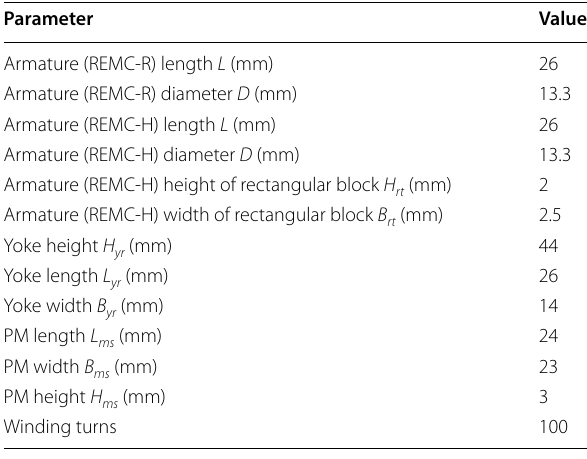
Table 1 Design parameters for prototypes